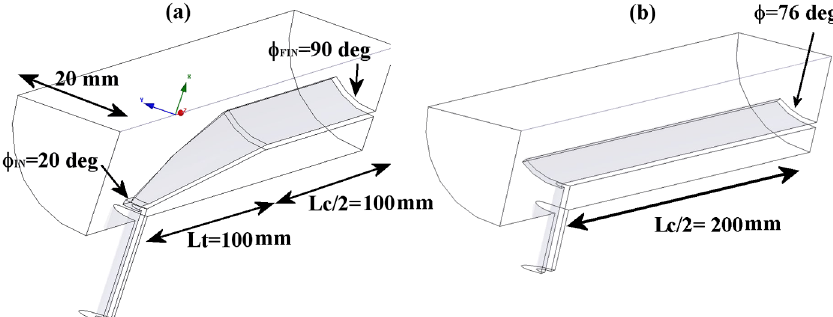
FIG. 14. GDFIDL simulated structures: (a) tapered; (b) not tapered.